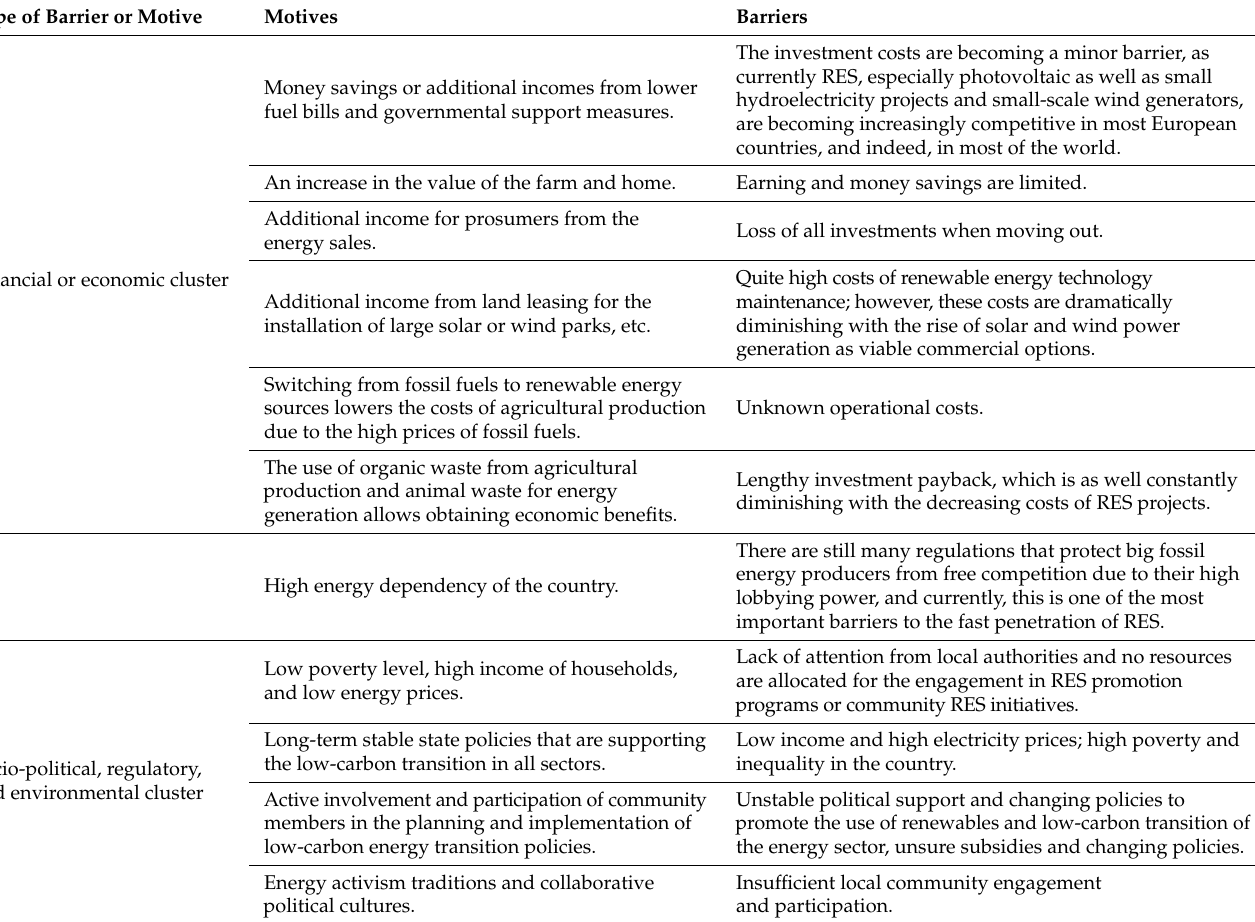
Table 1. Barriers and motives of renewable energy initiatives in rural